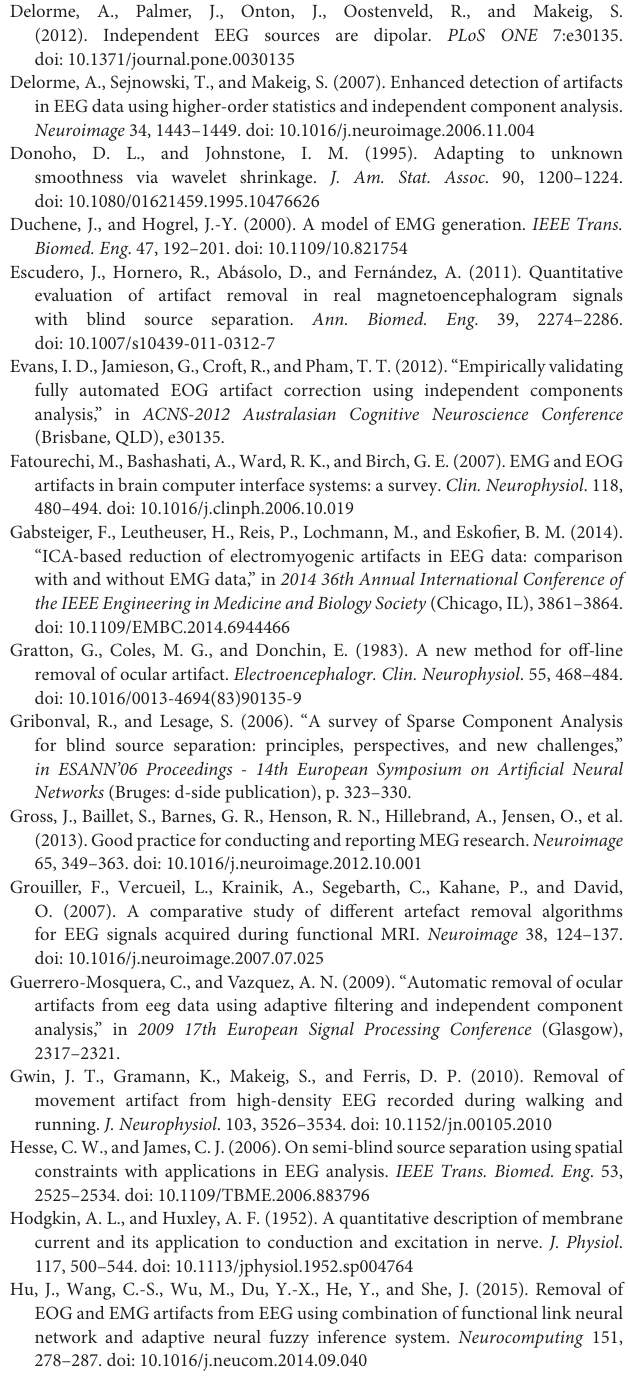
a common metric. Also, Supplementary Tables 1, 2 list the average thresholds for false positive and sensitivity test, respectively. Supplementary Table 3 lists the average artifact indices for the simulated EMG and conventional ICA